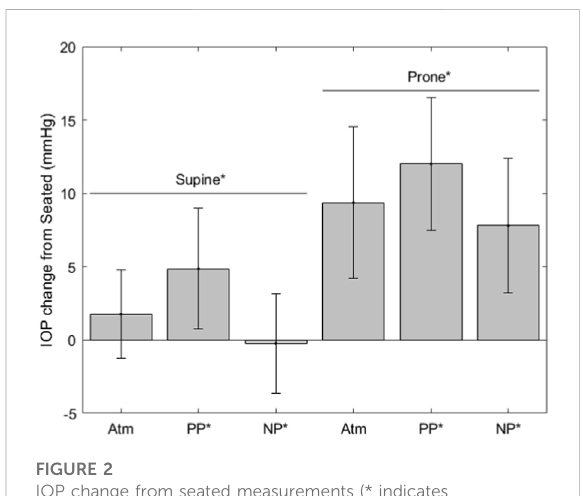
FIGURE 2 IOP change from seated measurements (* indicates signi fi cance,errorbarsindicatestandarddeviation,Atm=nolower body pressure, PP = lower body positive pressure, NP = lower body negative